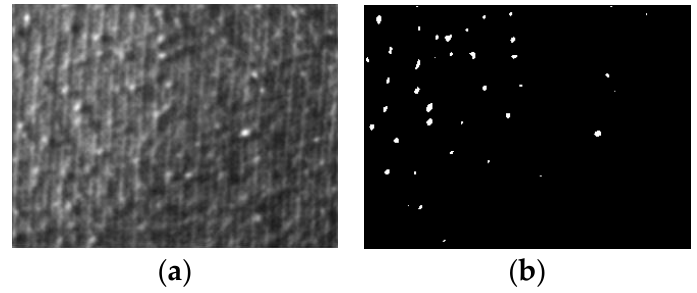
Figure 4. ( a ) IFFT image and ( b ) binarized image.